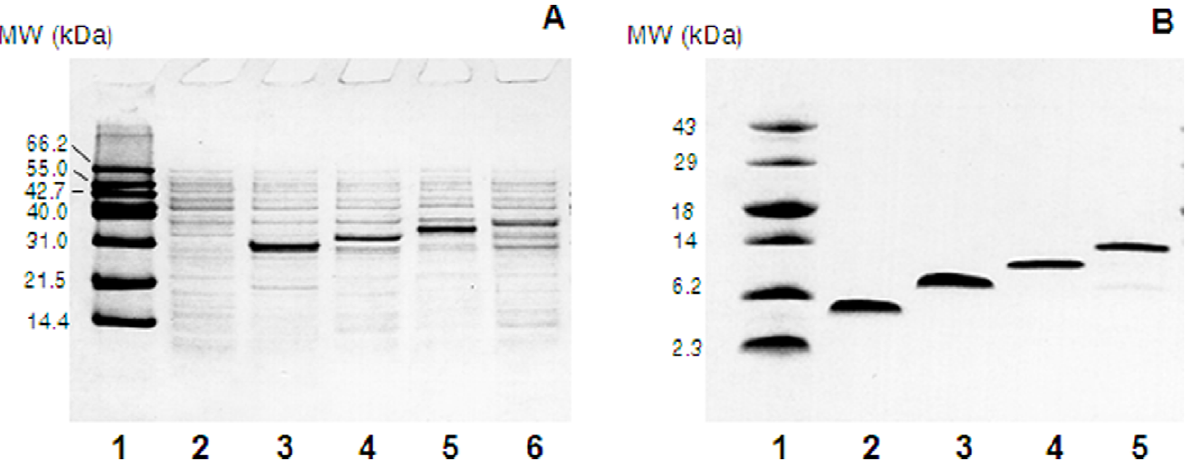
Figure 3. Expression of recombinant glutathion-S-transferse-histatin3 fusion proteins in E. coli BL21(DE3) using pGEX-3X as expression vector. A, Cell free extracts were analyzed on a 16.5% Tris-tricine SDS-PAGE. Lane 1, molecular weight marker; lane 2, pGEX-3x/His3-1 before induction; lane 3, induced pGEX-3x/His3-1; lane 4, pGEX-3x/His3-2; lane 5, pGEX-3x/His3-3; lane 6, pGEX-3x/His3-4. B, Tris-tricine SDS-PAGE of purified recombinant histatins. Lane 1, molecular weight marker; lane 2, reHst3 1-mer; lane 3, reHst3 2-mer; lane 4, reHst3 3-mer; lane 5, reHst3 4-mer.